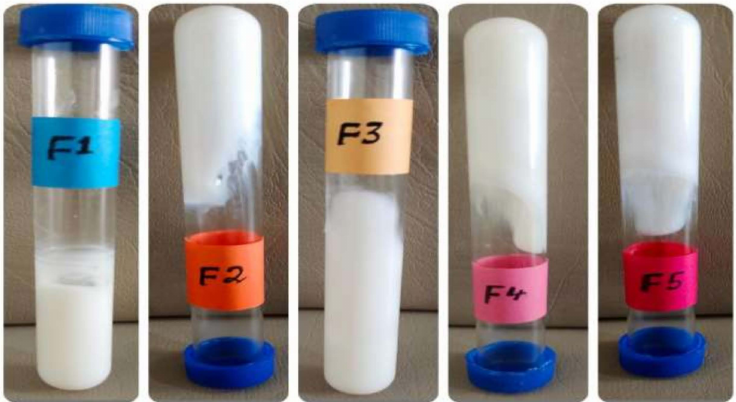
Figure 1. Stability of the produced formulations after centrifugation.